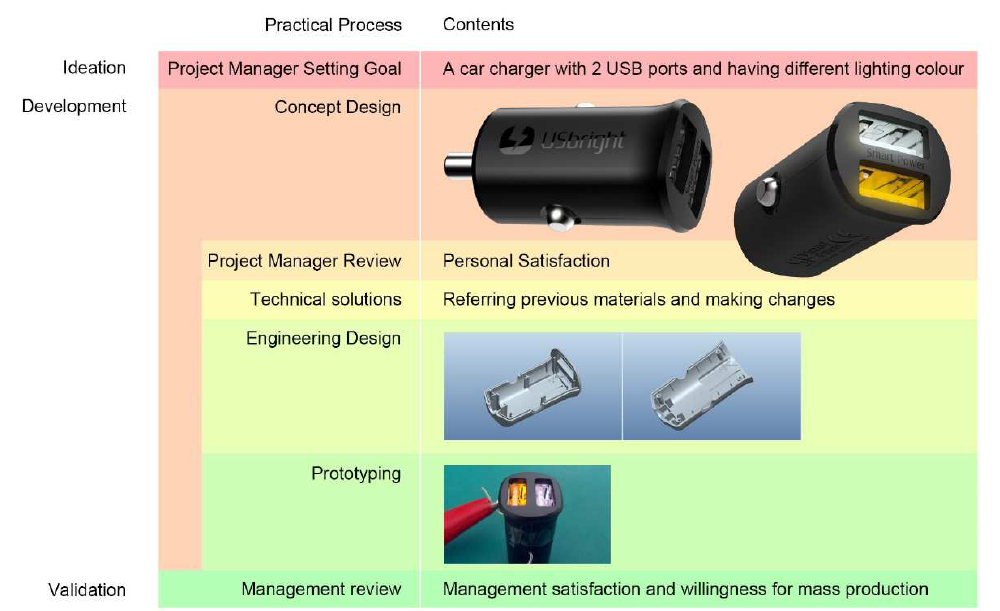
Figure 5: Conventional NPD Team Practical Application